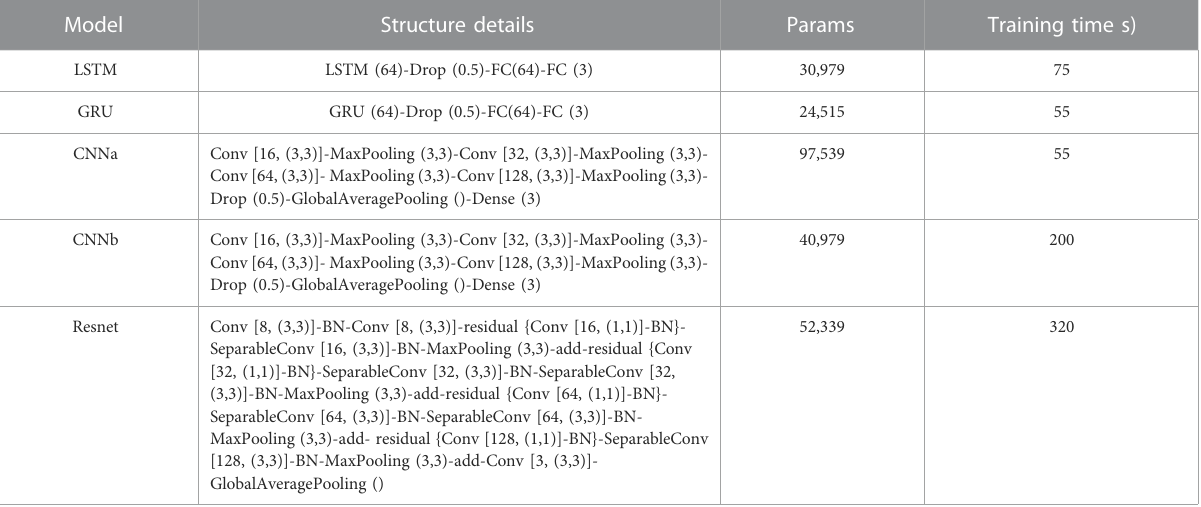
TABLE 4 The parameters of deep learning